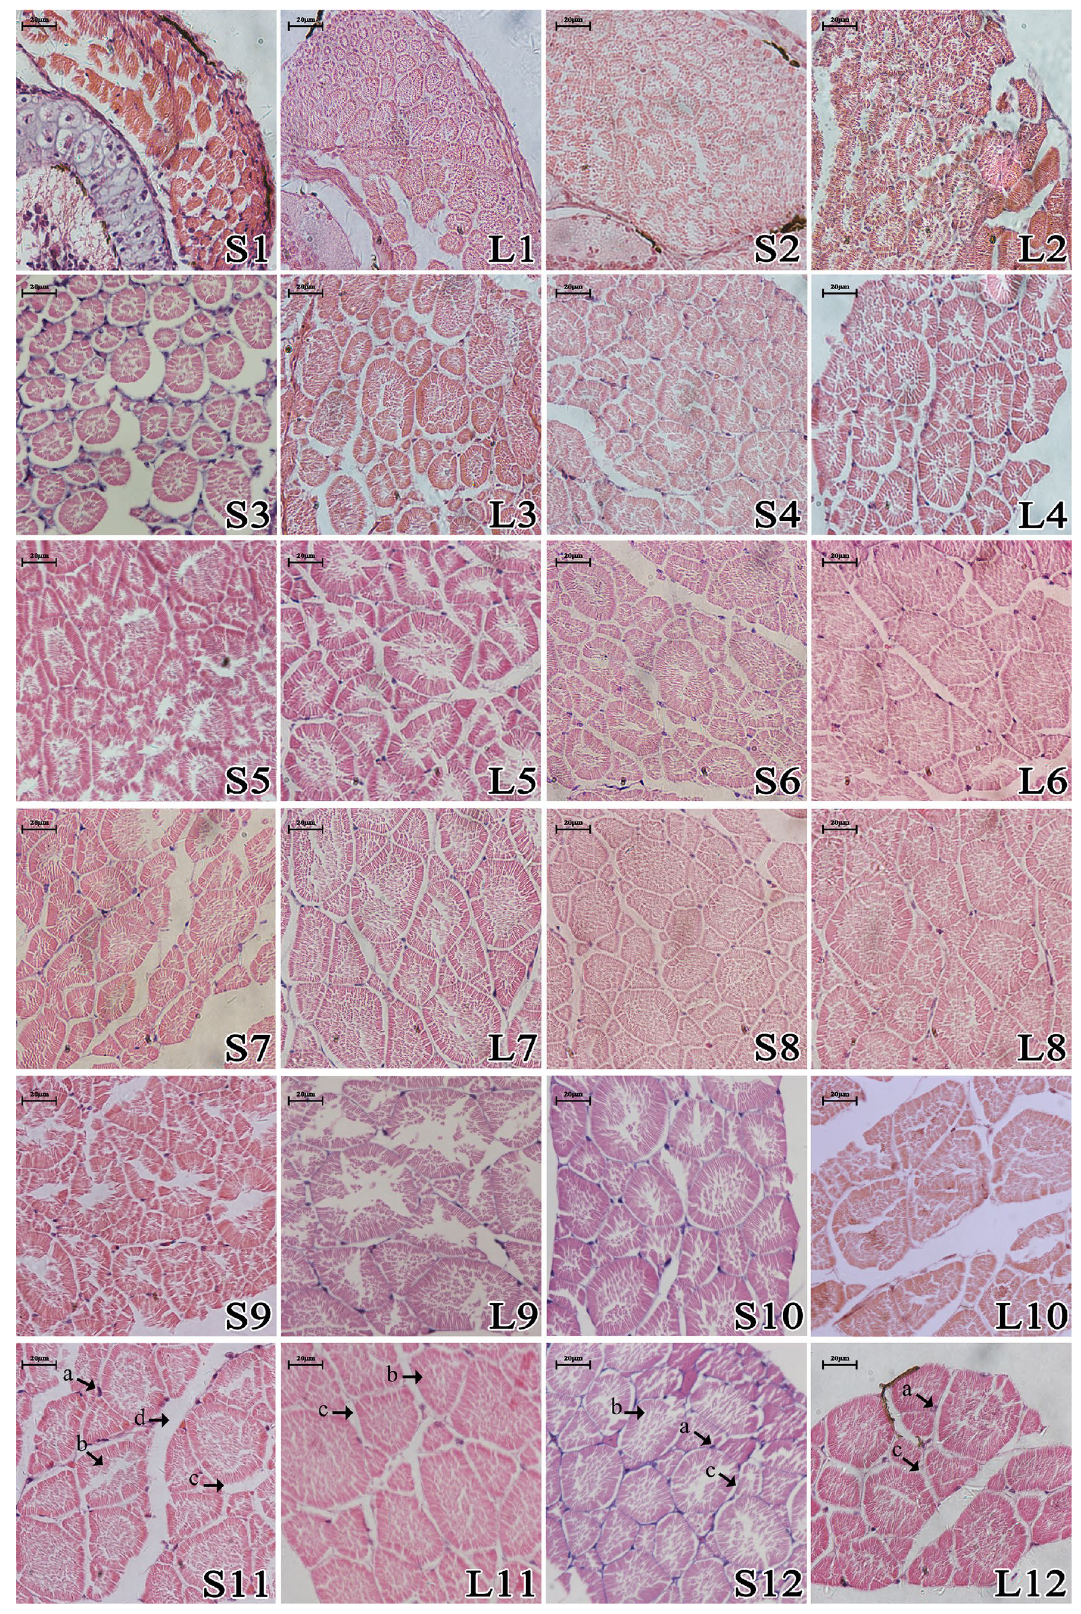
Figure 2. The weekly comparison of muscle histology between LG and SG loach. Note L large group, S small group; the number represents weeks. (a) Cell nucleus; (b) muscle fiber; (c) endomysium; (d)